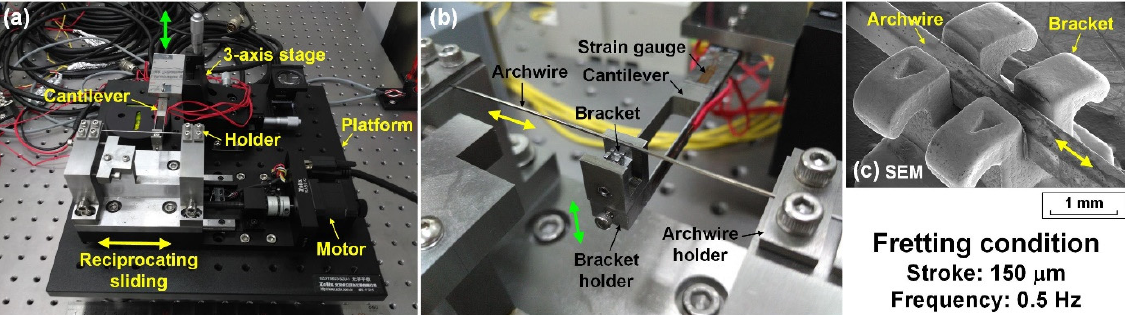
Figure 1. Experimental setup for the fretting wear tests. ( a ) Overview of the archwire–bracket reciprocating sliding tribometer. ( b ) Enlarged photo of contact combination of the stainless steel archwire and bracket. ( c ) SEM image of the contact combination of the stainless steel archwire and bracket.